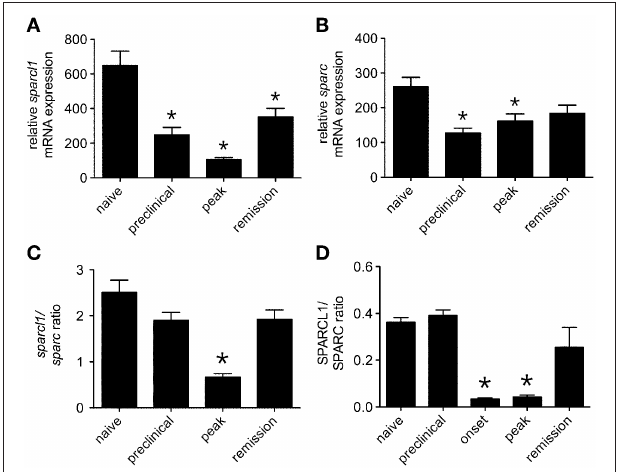
FIGURE 3 | The number of synapses in direct contact with the proximal dendrites or cell bodies of lumbar ventral motor neurons changes over the course of relapsing EAE. (A) A representative electron micrographic image showing the proximal dendrite of a ventral motor neuron (green) with multiple postsynaptic densities (arrows) indicative of individual synapses (red), Bar = 500nm. (B) Quantification of these synaptic contacts at different stages of relapsing EAE shows evidence of synaptic retraction from the perikarya of motor neurons (MN) at peak disease with full reestablishment of these structures around MN several days later in the setting of disease remission ( n = 10 MN from each of 3 mice at each disease stage), * p < 0.05 naïve versus peak and peak versus remission. (C) A representative electron micrograph at peak disease shows many synapses (red, with arrows) displaced from a motor neuron cell body (green), Bar = 2 µ m. (D) Another representative electron micrograph at higher magnification shows the physical separation of an axosomatic synapse (red) from the cell body of a ventral motor neuron (green), without any other cellular process interposed between the two structures, Bar = 500nm.